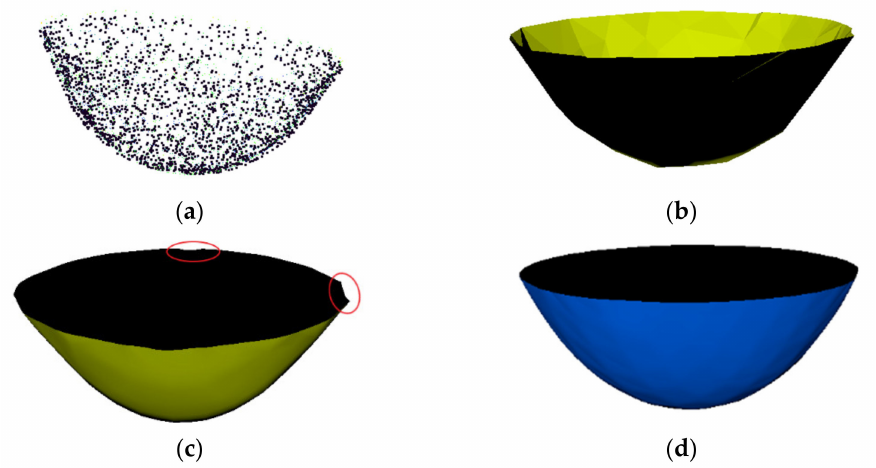
Figure 8. ( a ) Point set of a bowl; ( b ) surface reconstructed using Poisson; ( c ) PDE-based surface using single 16-variables PDE model; ( d ) PDE-based surface using single 64-variables PDE